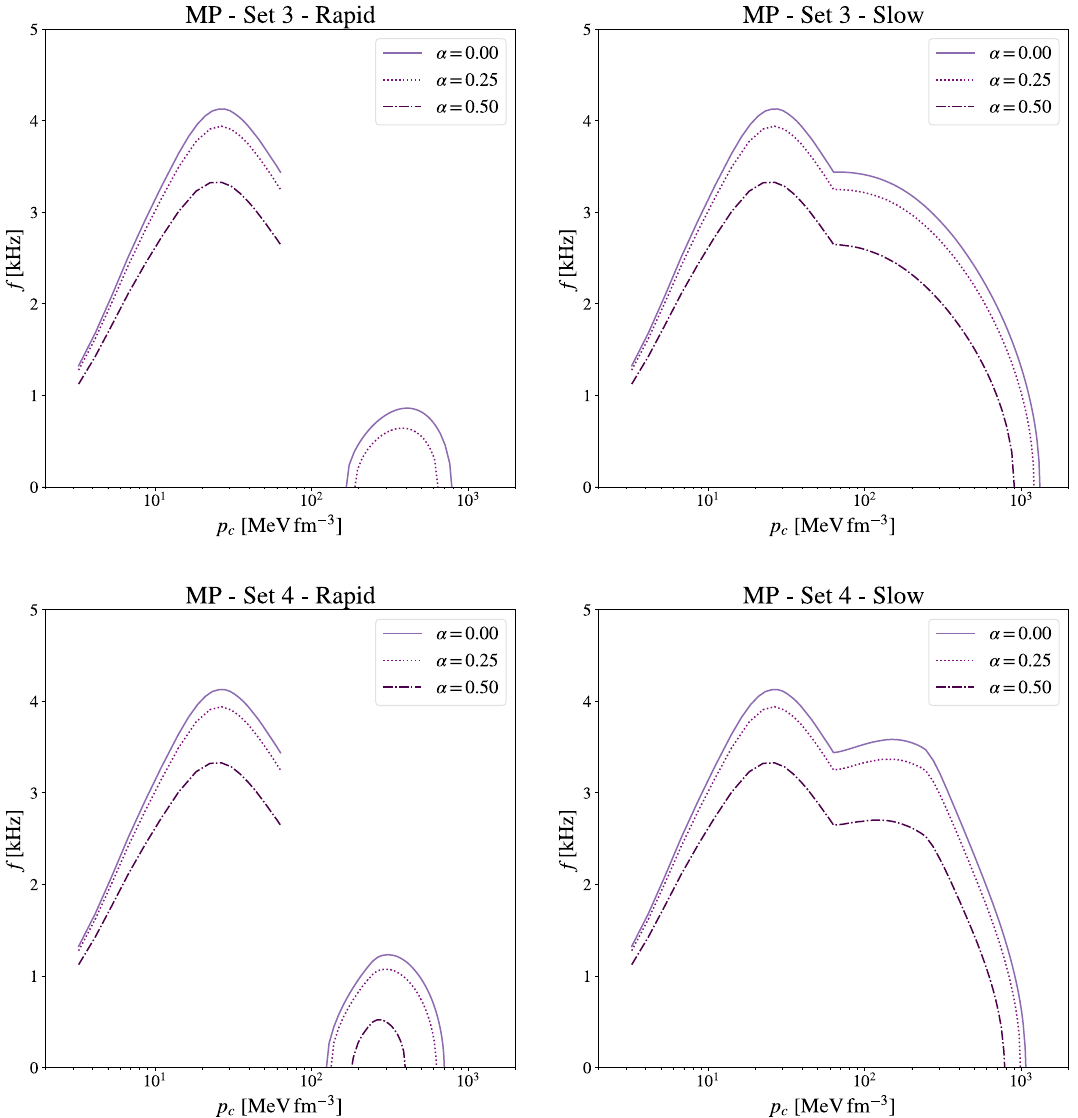
Fig. 6 Predictions for the fundamental linear eigenfrequency as a function of central pressure for charged twin stars, considering rapid (left panels) and slow (right panels) conversions and the Set 3 (upper panels) and Set 4 (lower panels) of the MP approach for the QM